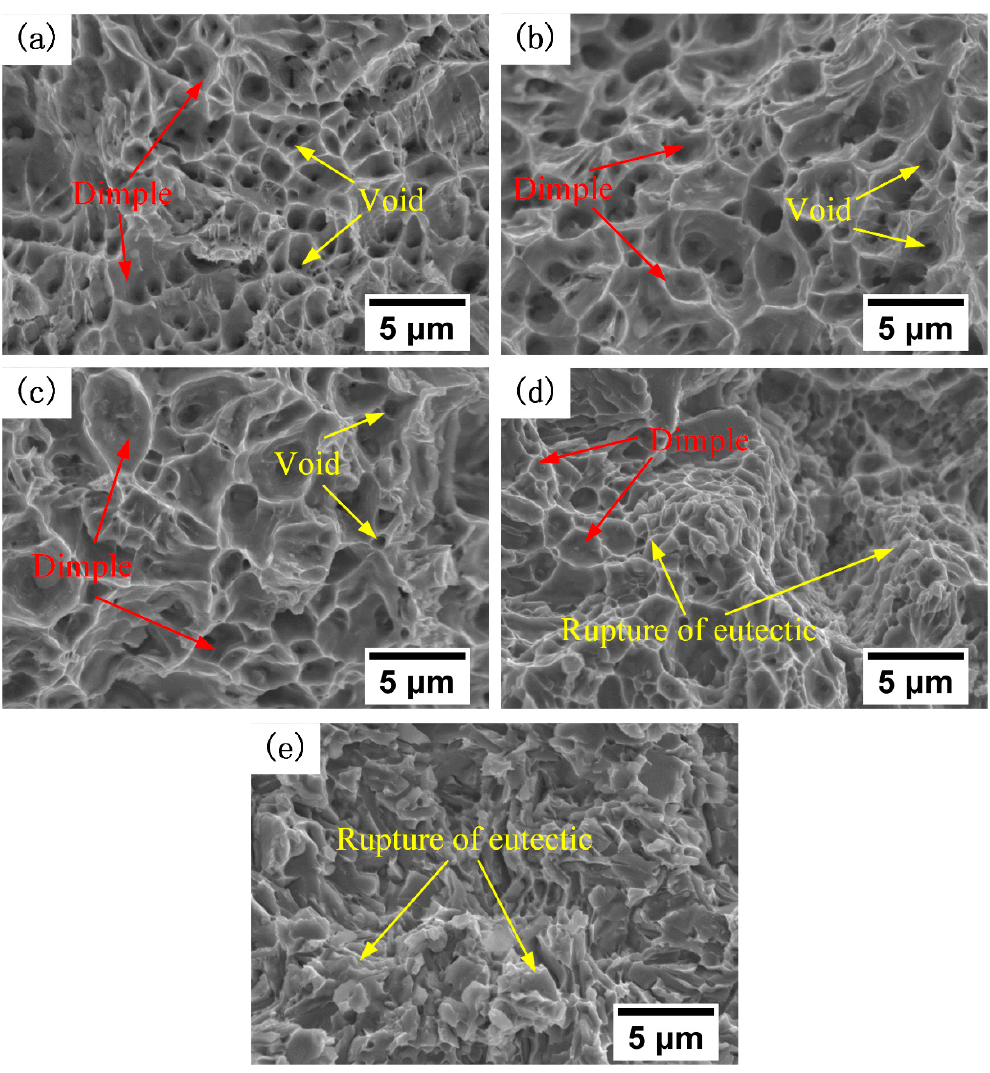
Figure 11. SEM micrographs of the fracture surface of deposited ( a ) 410L, ( b ) 410L + 6.25% Fe–Cr–B– Si–Mo, ( c ) 410L + 12.5% Fe–Cr–B–Si–Mo, ( d ) 410L + 25% Fe–Cr–B–Si–Mo, and ( e ) Fe–Cr–B–Si–Mo alloys,